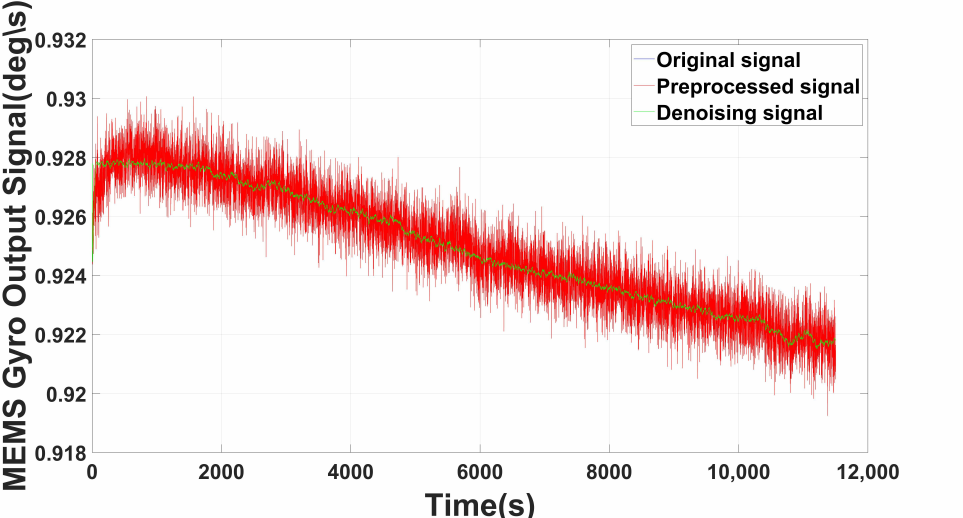
Figure 8. Denoising result of ICELMD (without abnormal